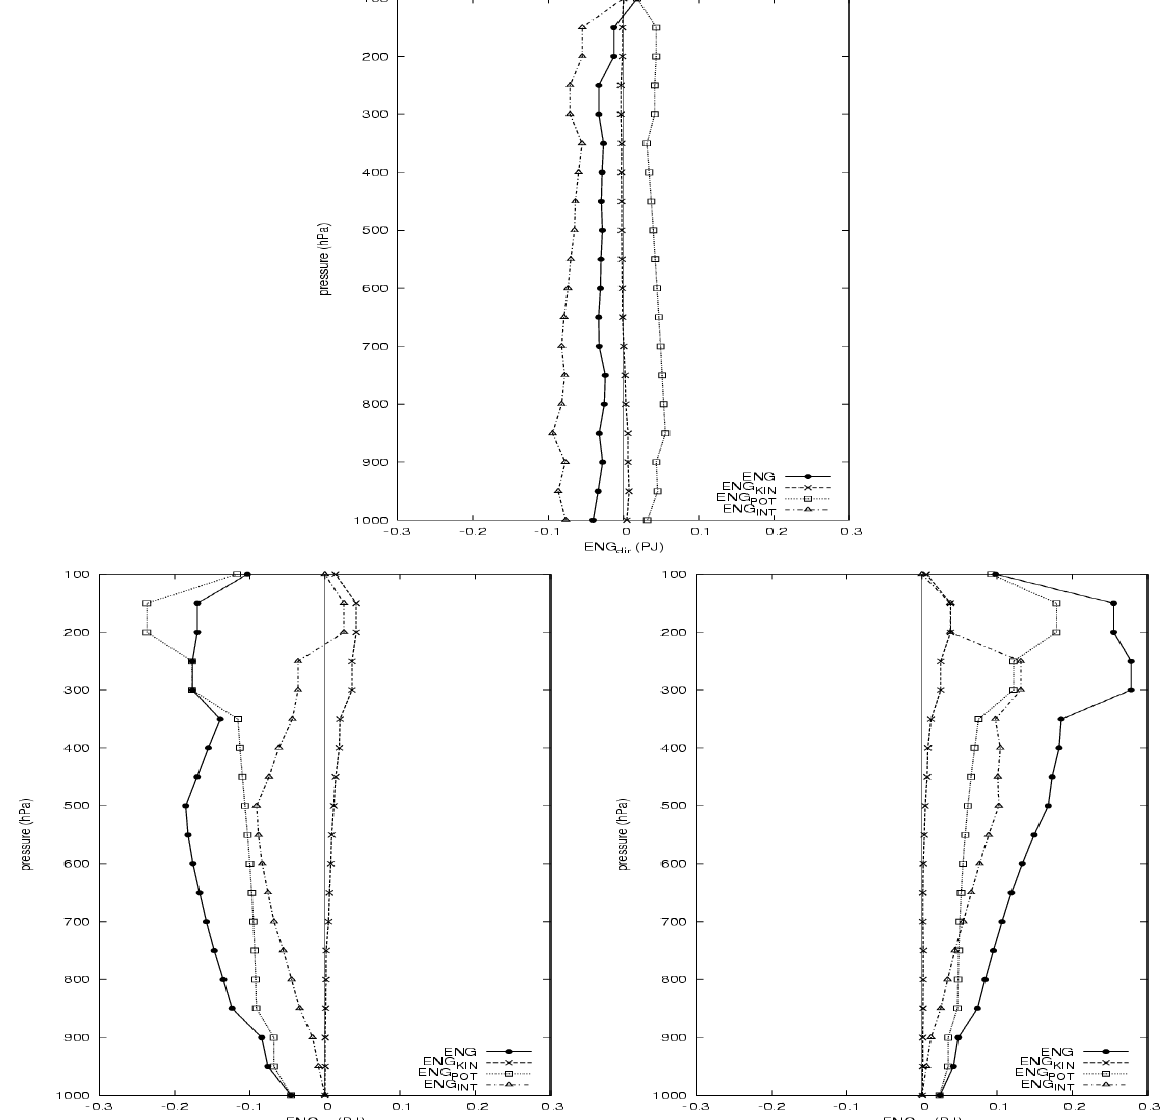
Fig. 9. Vertical profiles of the horizontally averaged total variations of energy (in PJ) according to the positive percentage of modification for each anomaly. Total energy variation (solid line, filled circles), Potential energy ( ENG pot , dotted line with squares), Kinetic energy ( ENG in , dashed line with crosses), Internal energy ( ENG int , dot-dash line with triangles). ErPVpTerm (top), ErPVp01 (bottom left), ErPVpHigh (bottom